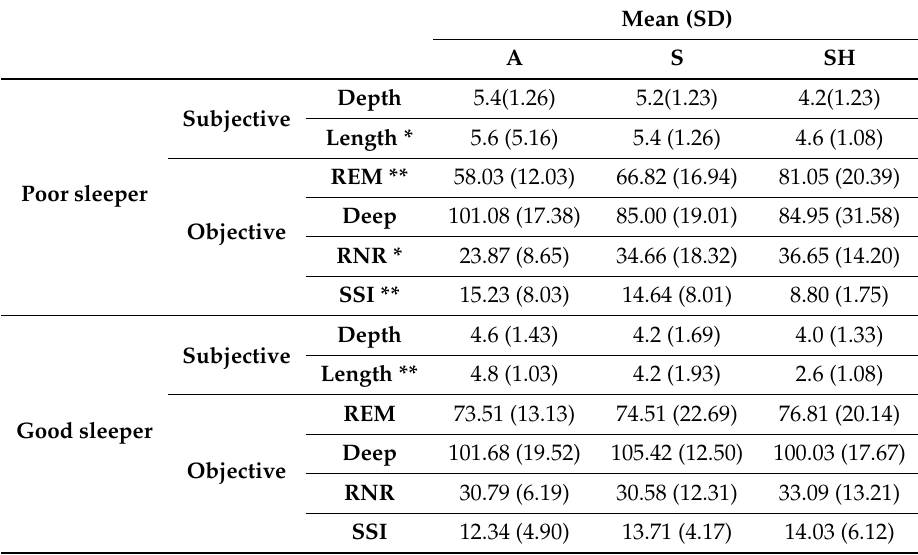
Table 3. Comparison of subjective and objective sleep evaluation between poor sleepers and good